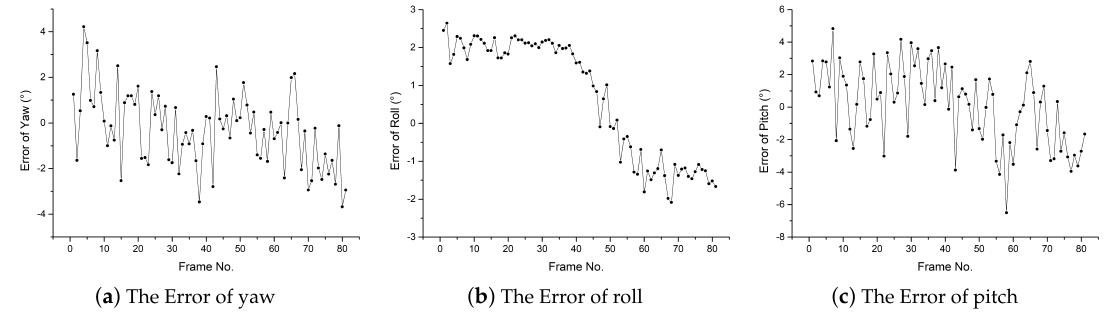
Figure 13. Error of attitude